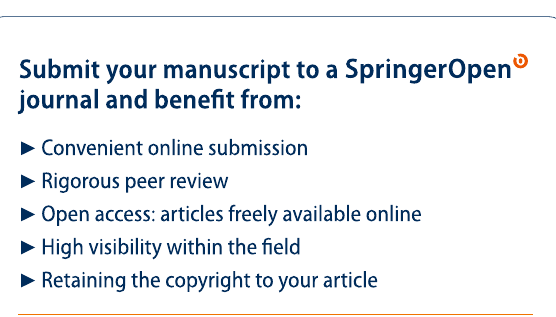
World Health Organization (WHO) (2015) Healthy diet. Fact sheet number 394. World Health Organization, Geneva, Switzerland. Accessed 10 Mar 2017. Yang RY, Keding GB (2009) Nutritional contributions of important African indigenous vegetables, pp. 105-143. In: Shackleton CM, Pasquini MW, Drescher AW (eds) African indigenous vegetables in urban agriculture. Earthscan, London Yau KW, Wang K, Lee AH (2003) Zero-inflated negative binomial mixed regression modelling of over-dispersed count data with extra zeros. Biometrical J 45(4):437 –